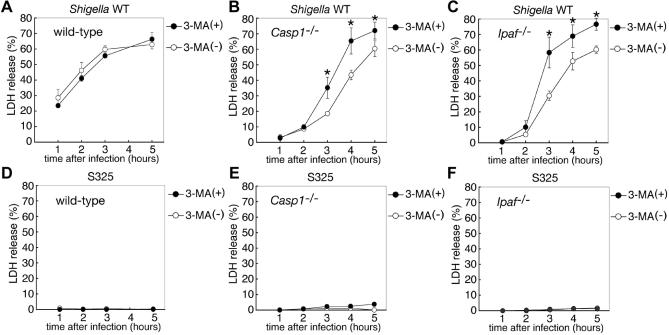
Autophagy Inhibitor 3-MA Enhances Caspase-1-Independent or Ipaf-Independent Cell Death of Macrophages Infected with Shigella
Wild-type (A and D), caspase-1-deficient (B and E), or Ipaf-deficient BMMs (C and F) were infected with Shigella WT (A–C) or TTSS mutant (S325) (D–F) in the presence or absence of 3-MA (10 mM). Error bars represent mean ± SD. *, p < 0.05 (Mann–Whitney U test).